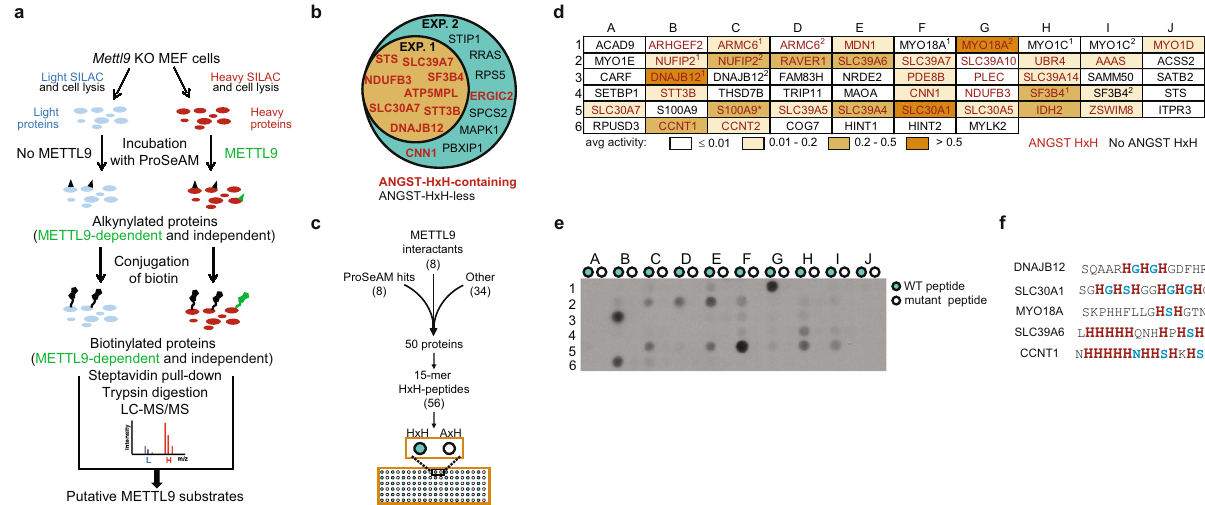
Fig. 3 Identi fi cation of new cellular and peptide substrates of METTL9. a Outline of the ProSeAM (propargylic Se-adenosyl- L -selenomethionine) assay for identi fi cation of novel METTL9 substrates in cell extracts. b Venn diagram of mMETTL9 substrates identi fi ed in the two ProSeAM experiments. HxH- containing proteins are in red. c Schematic of array design for METTL9 substrate assessment. d Relative average MTase activity (from two independent arrays) presented in shades of orange, with gene names of relevant peptides indicated (ANGST HxH-containing in red). Superscripts denote multiple peptides derived from the same protein. All peptides are derived from human proteins, except mouse S100A9 (asterisk). Note that the array also contained an additional, HxH-less, peptide, based on the previously reported histidine-methylated sequence from MYLK2. e Representative result of METTL9- mediated methylation of a peptide array designed as in c and with each coordinate (e.g. A1) representing WT (HxH-containing; teal) and control (HxH-less; white) versions of a unique sequence (see also Supplementary Table 1). The experiment was performed twice with similar results. f Sequences of the top